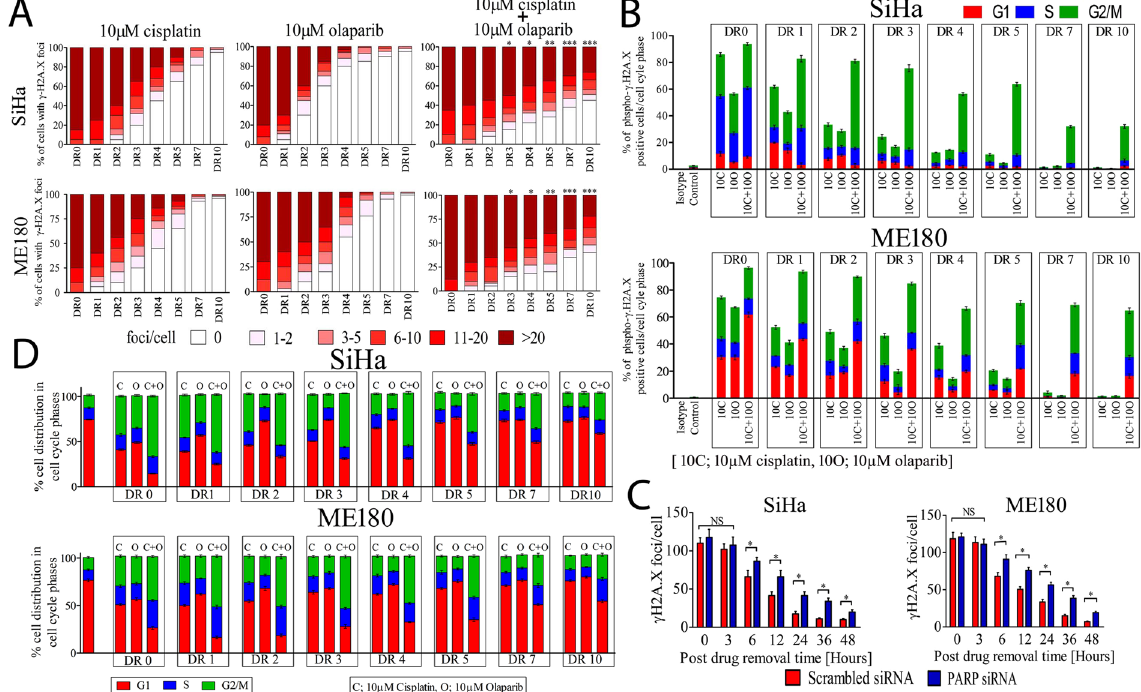
Figure 7. PARP1 inhibition delayed DNA repair and leads to prolonged cell cycle arrest at G2/M. ( A ) Both the cell lines SiHa and ME180 were treated with 10 µ M cisplatin and/or olaparib for 24 hrs. After 24 hrs drug was removed (DR0) and fresh drug free media was added. Cells were cultured further and γ H2A.X foci were observed very 24 hr till 10 days post drug removal (DR0 to DR10). Cells with > 20 γ H2A.X foci to 0 foci were counted in blind fashion and at least 200 cells per group in several different 60 × objective fields were acquired. Quantitative plot displaying distribution of γ H2A.X foci in three treatment groups in both the cell lines. [Time point DR3, frequency of cells with more than 20 foci per cell in SiHa; cisplatin vs. cisplatin + olaparib * p = 0.0467, at DR4; cisplatin vs. cisplatin + olaparib * p = 0.0268, at DR5; cisplatin vs. cisplatin + olaparib ** p = 0.0060 and frequency of cells with more than 20 foci per cell in ME180 at DR3; cisplatin vs . cisplatin + olaparib * p = 0.0390, at DR4; cisplatin vs . cisplatin + olaparib * p = 0.041, at DR5; cisplatin vs . cisplatin + olaparib ** p = 0.0024]. (B ) Both the cell lines SiHa and ME180 were treated as indicated and cell were stained with FITC tagged anti γ H2A.X & co-stained with PI and analysis was done using FACS for DNA damage in each cell cycle phases. Graph showing the percentage of cells with γ H2A.X foci in SiHa and ME180 cell lines. PARP1 inhibition in cisplatin treated cells shows significant accumulation of DNA damage in late S and G2/M phase compared to G1. ( C ) Graph showing frequency of γ H2A.X foci resolution in PARP1 silenced and control counterpart after cisplatin treatment. PARP1 silenced cells displayed significant delay in γ H2A.X foci resolution after drug removal. ( D ) Similarly, PARP inhibition along with cisplatin treatment for 48 hrs shows significant & prolonged G2/M and late S phase arrest in both the cell lines after drug removal as in previous